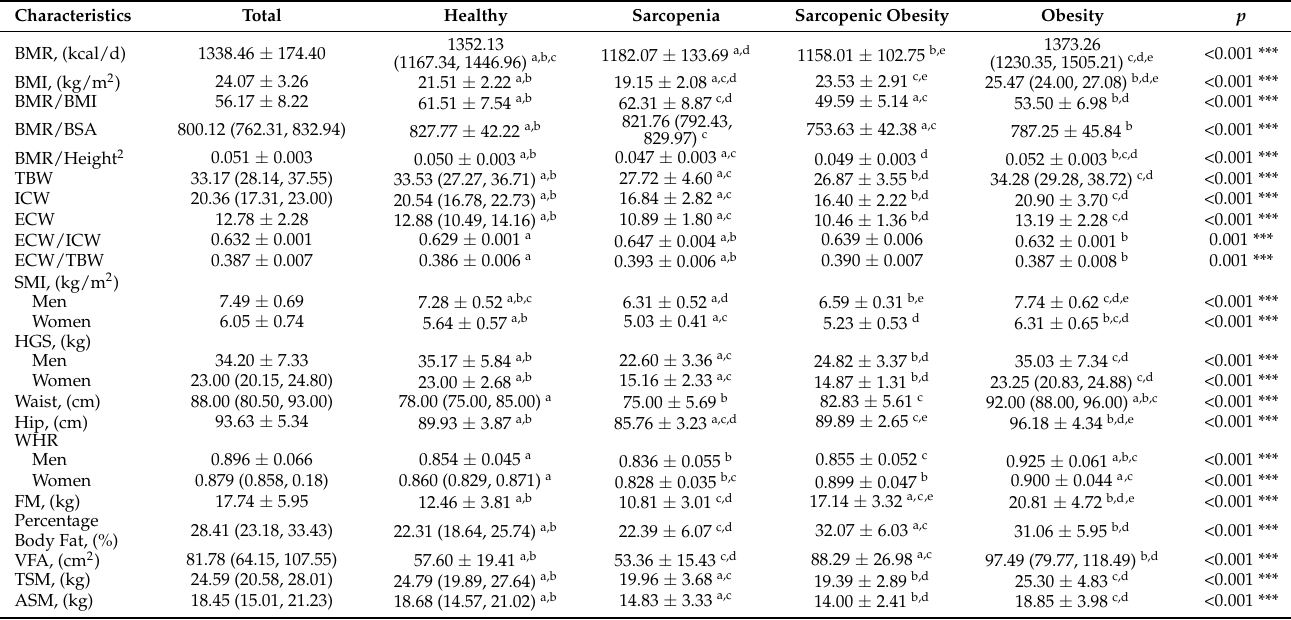
Table 1. Body composition